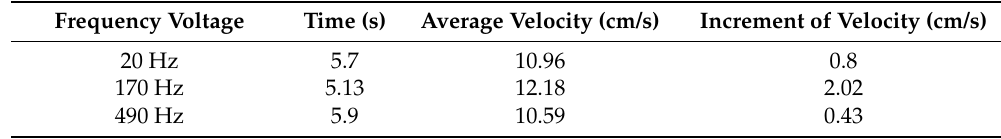
Table 8. The average flow velocity and the velocity increment of the pump with a single bimorph.